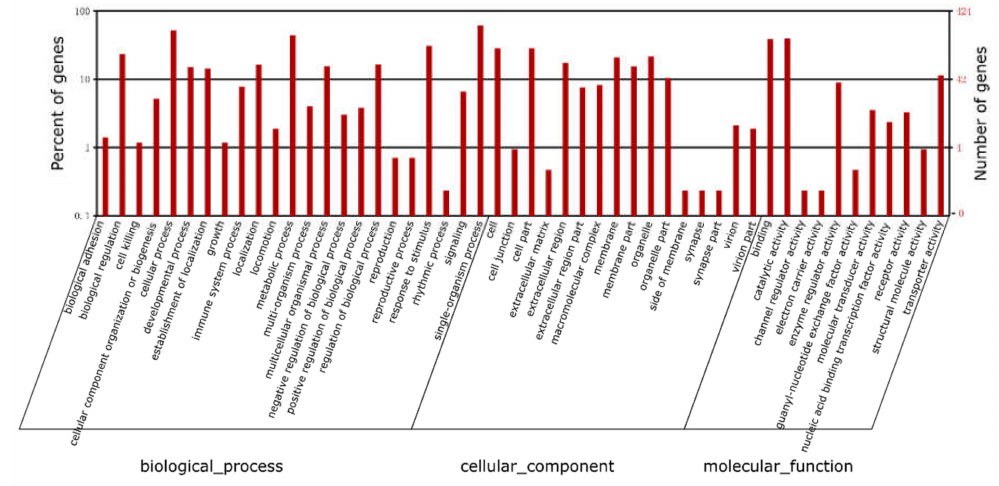
Figure 6. Gene ontology enrichments of all differentially expressed genes responded to miR-34a inhibitor treatment.